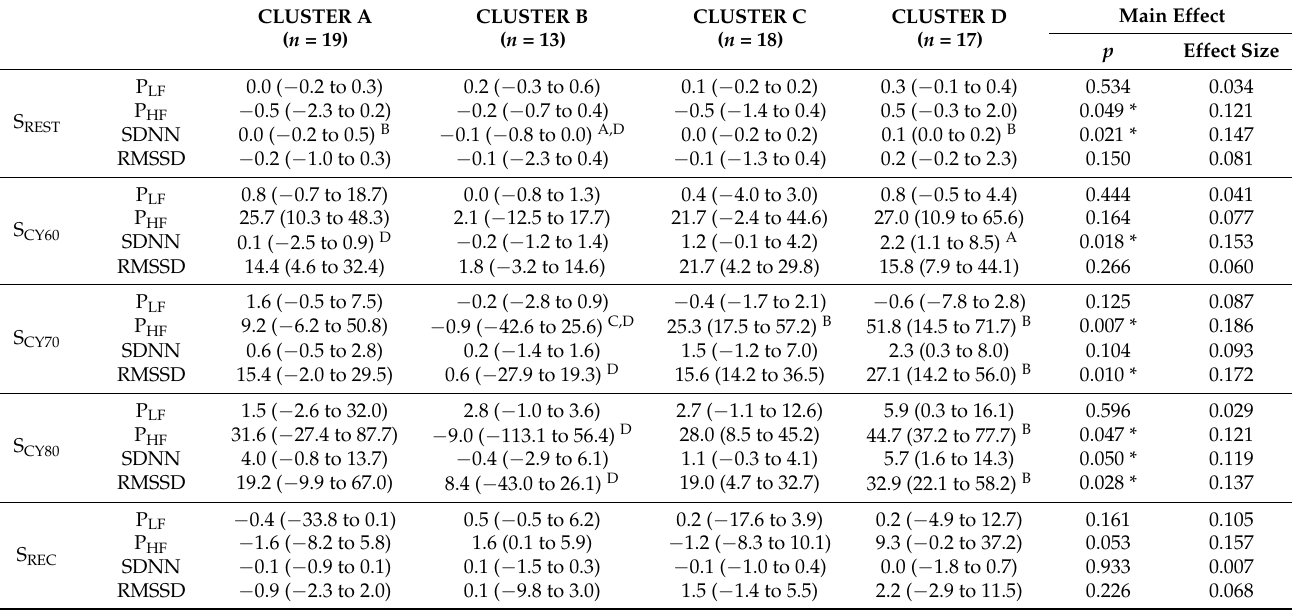
Table 5. Percentage of error (%) for each HRV index and comparison between